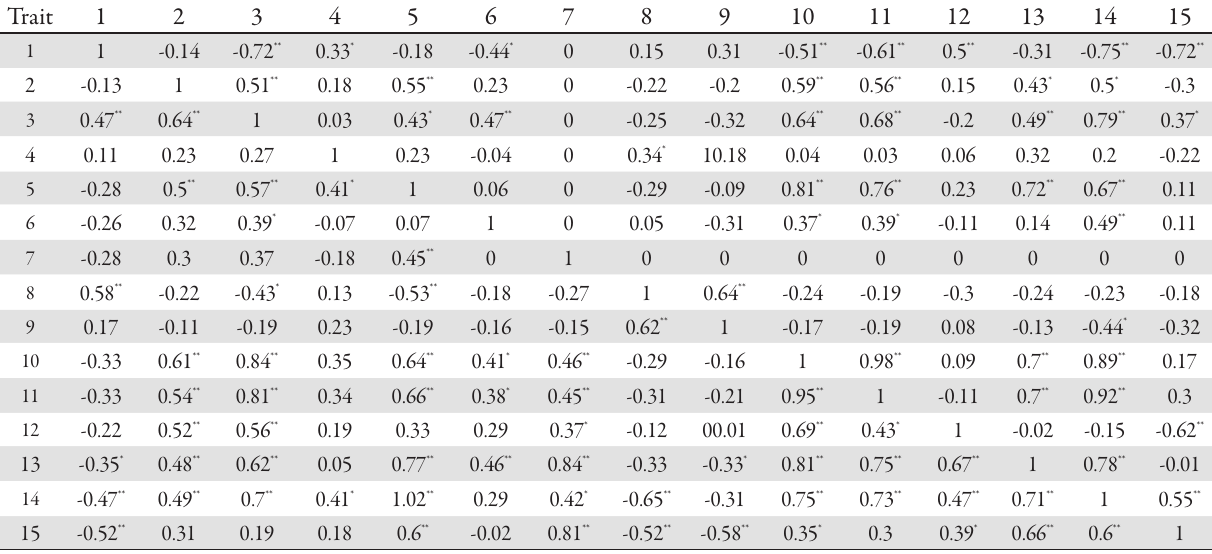
Tab. 6. Genotypic correlation coefficients between traits in 30 rice cultivars under two irrigation regimes, optimum irrigation (up) and drought stress (down)